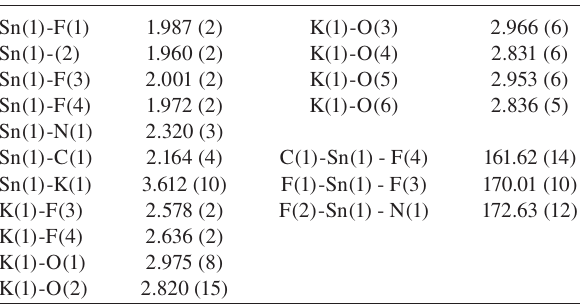
NCH ) C H }- 2 2 2 6 3